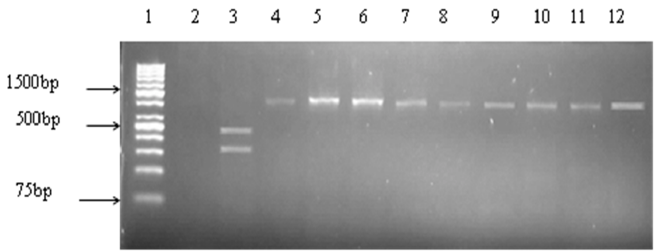
Figure 5. Representative gel of PCR RFLP of Vibrio vulnificus vvhA gene. Lane 1: molecular weight marker (1 kb plus), lane 2: negative control, lane 3: V. vulnificus biotype 3, lanes 4–12, V. vulnificus